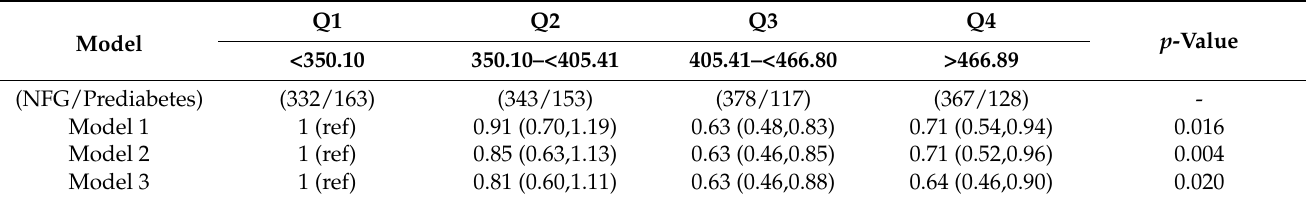
Table 5. Multivariable-adjusted relationship between magnesium intake (mg/day) and predia- betes risk.